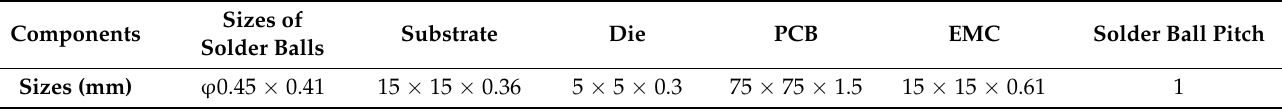
Table 2. Material properties of components in the BGA package [17].